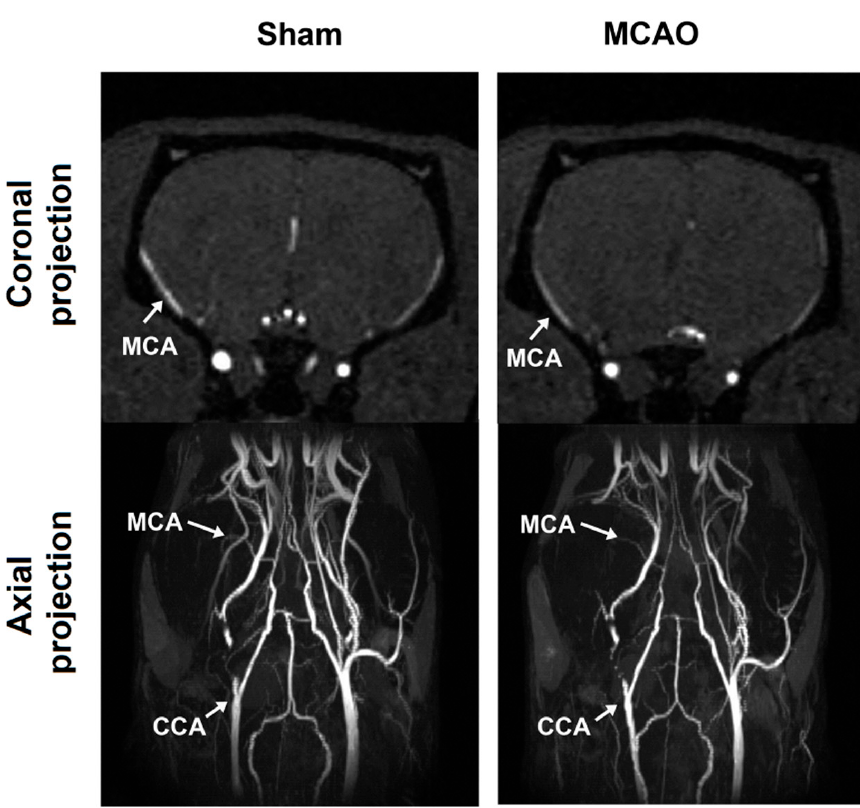
Figure 10. Representative images of magnetic resonance angiography in coronal ( top ) and axial ( bottom ) projections after sham and MCAO surgery. White arrows show the presence of blood flow in the common carotid artery (CCA) and middle cerebral artery (MCA).